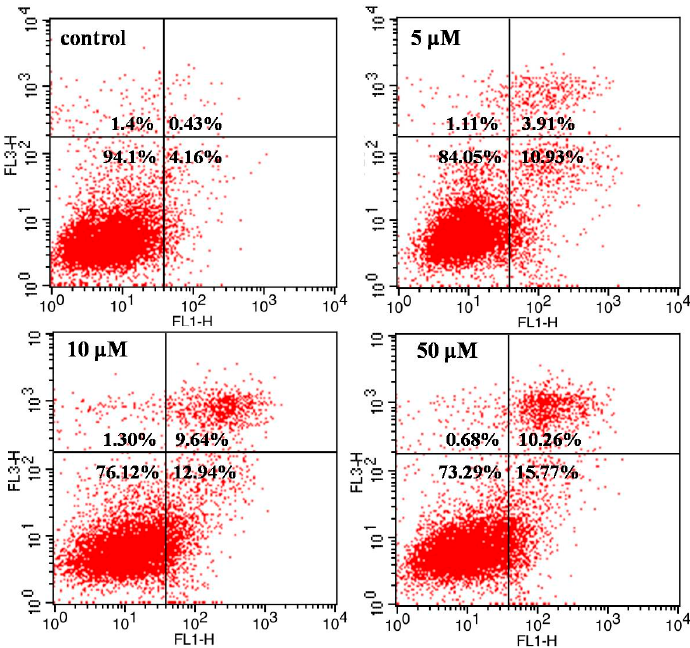
Figure 4. The apoptosis analysis of MCF-7 cell treated with V 18 for 24 h.